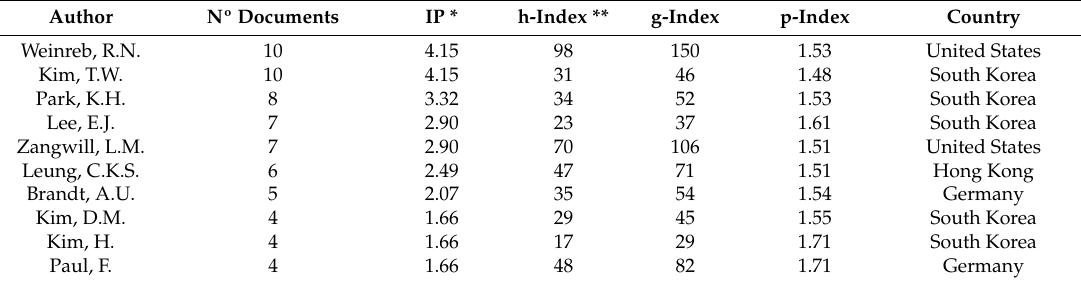
Table 3. Most productive authors.